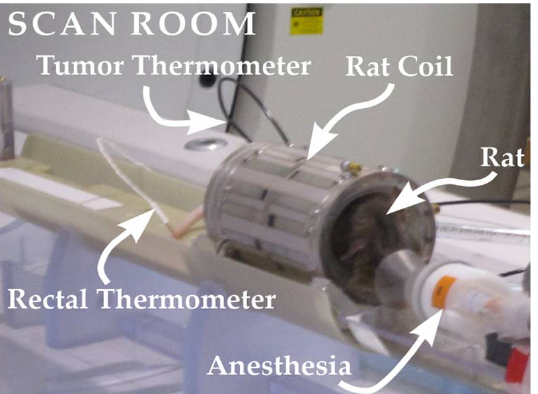
Figure 1. Setup used for imaging/heating experiments in rats (shown without oil vials, or insula- tion). Rats were administered an isoflurane anesthesia and placed into a rat-sized transmit/receive MRI coil. The core body temperature of the rat was monitored rectally by a calibrated fiber-optic thermometer. The rats were stabilized at temperatures for 10 min to achieve a steady state before imaging experiments began.